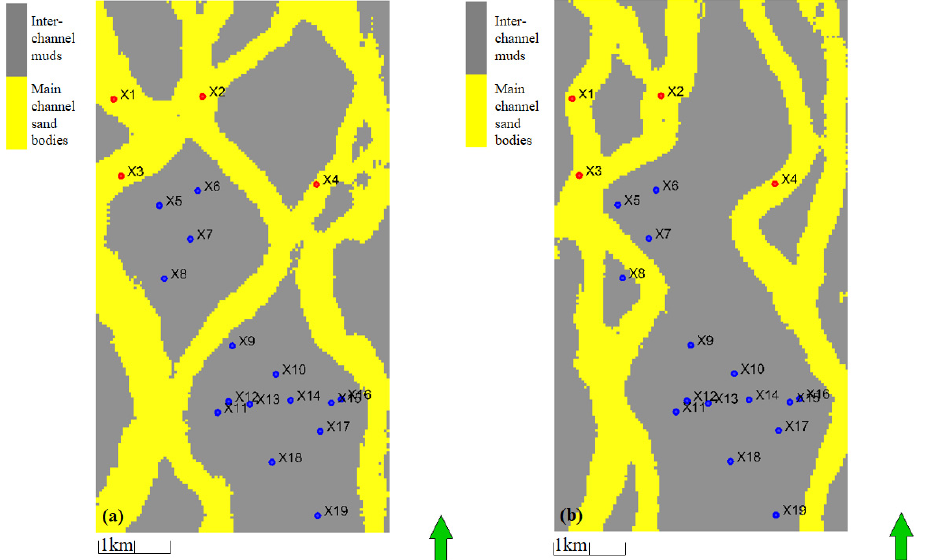
Figure 16. The facies model of NG1 layer in X area of Shengli Oilfield established by the UCSC method. ( a ) Realization1; ( b ) Realization2.